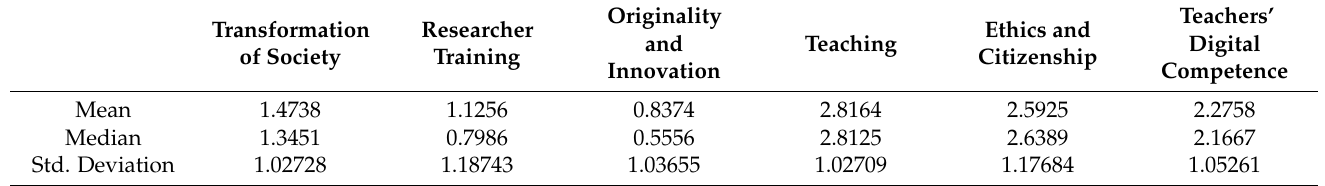
Table 8. Research Professors’ Self-assessment of Competencies (N = 320).